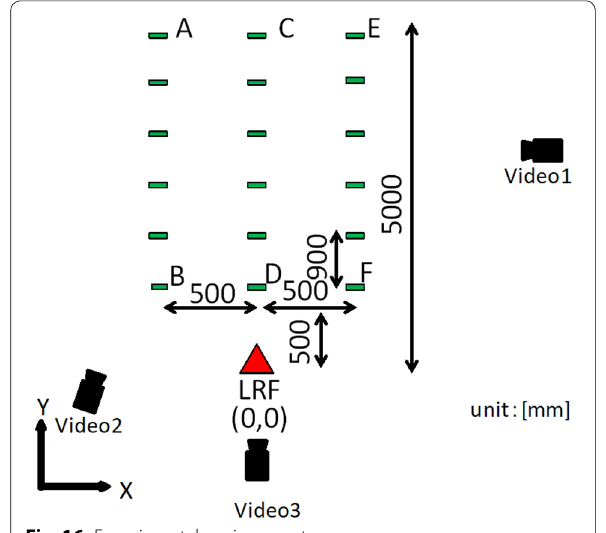
Fig. 16 Experimental environment